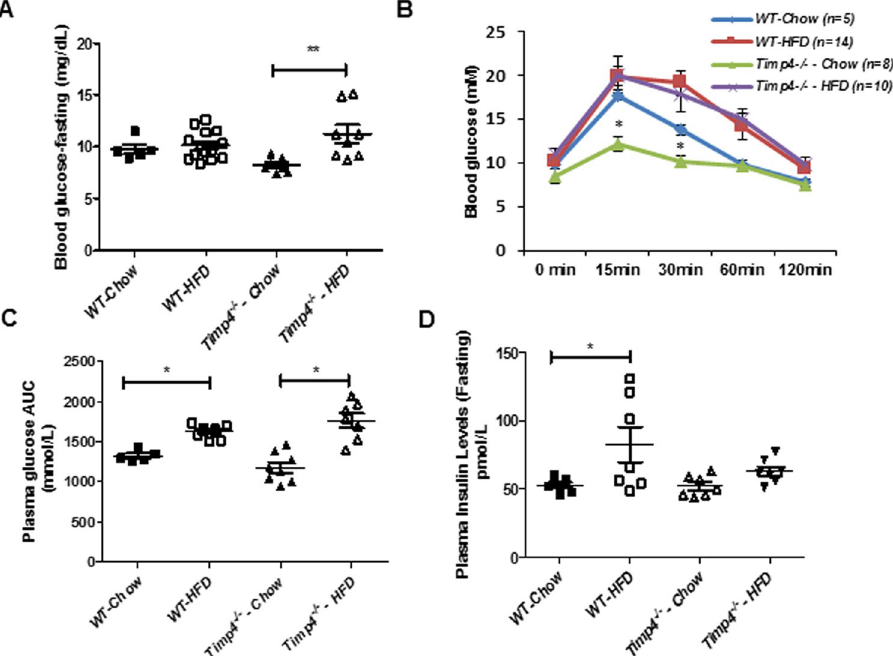
Figure 6. Timp4 gene deletion protects mice from HFD-induced hyperinsulinemia but not from glucose intolerance. Fasting plasma glucose levels ( A ), blood glucose levels during an oral glucose tolerance test (OGTT) ( B ), and the averaged area under curve (AUC) for indicated groups ( C ). ( D ) Fasting plasma insulin levels. Averaged data are presented as mean ± S.E. and analyzed by ANOVA. * indicates significance (p < 0.05) between WT chow-fed and TIMP4KO chow-fed